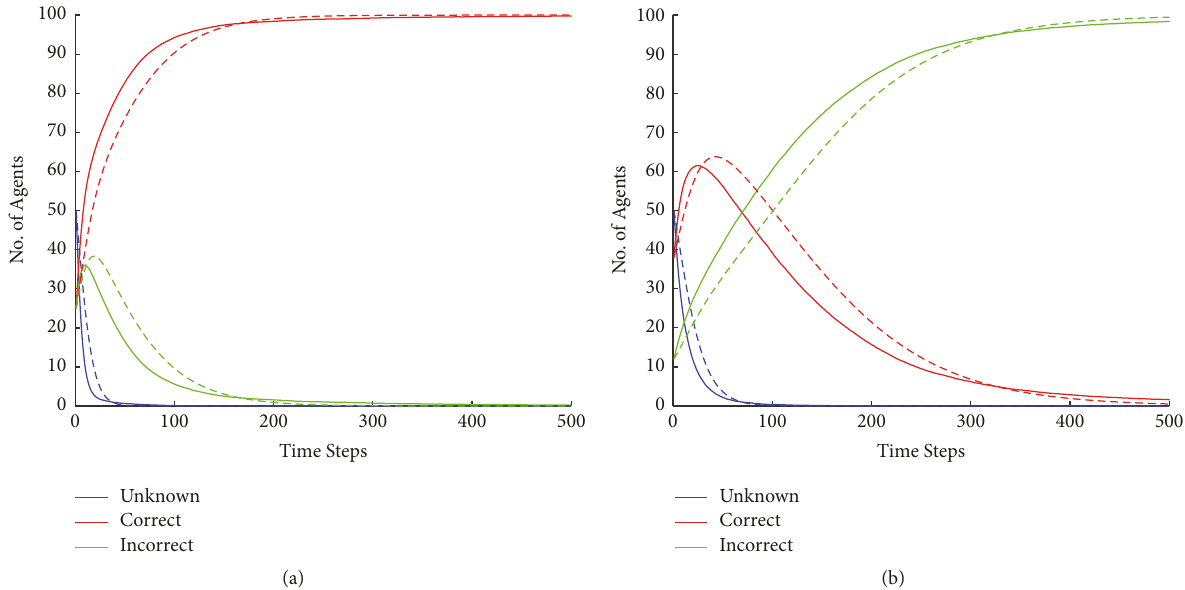
Figure 7: Results against both scenarios where SINK has low trust in the community. (a) HLM case against “nominal scenario”; (b) HML case against “wishful-thinking scenario.”